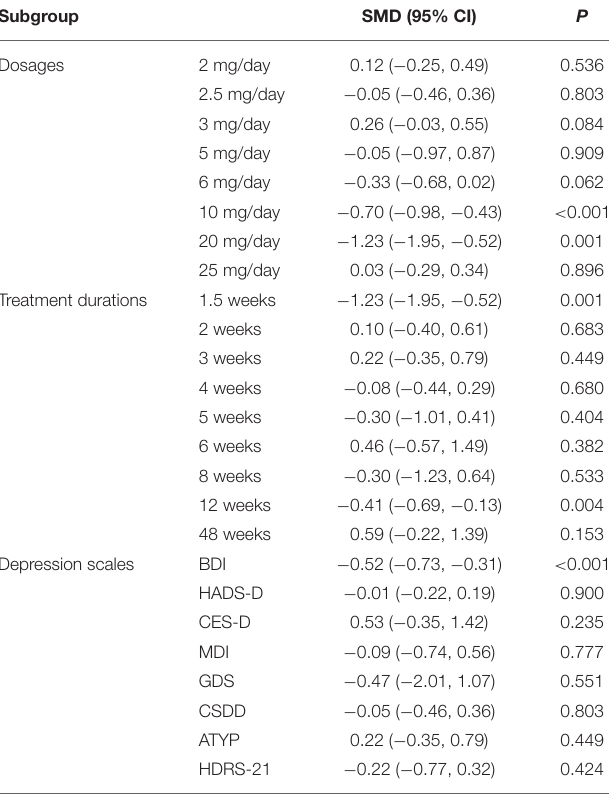
TABLE 2 | Subgroup analyses on the effect of melatonin on depressive symptoms.